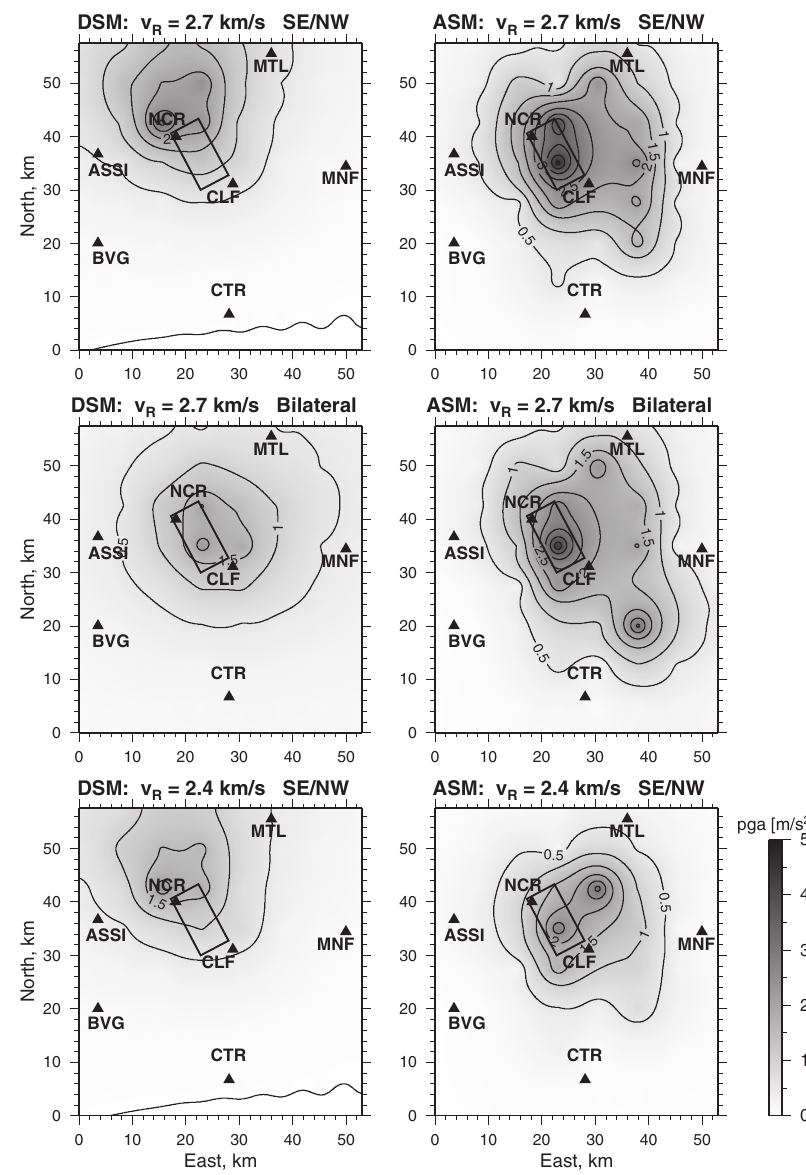
Fig. 4. Maps of mean synthetic PGA obtained for the Colfiorito earthquake using the DSM and the ASM sim- ulations. Top panels: unilateral SE/NW nucleation for a constant rupture velocity of 2.7 km/s; middle panels: bi- lateral nucleation a constant rupture velocity of 2.7 km/s; bottom panels: unilateral SE/NW nucleation for a con- stant rupture velocity of 2.4 km/s. For all rupture models, the mean value of PGA is computed at each site from the distribution of peak values obtained from synthetics simulated by moving the nucleation point on the bottom half of the Colfiorito